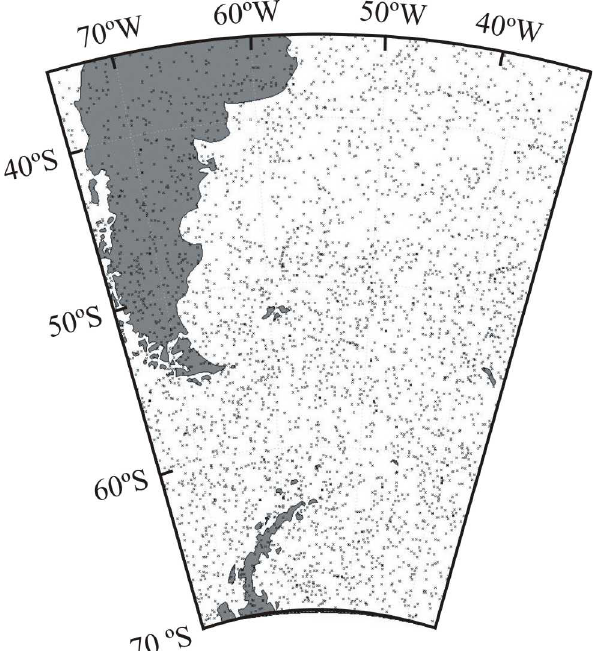
Fig. 1. The region studied and the geographical distribution of RO represented by